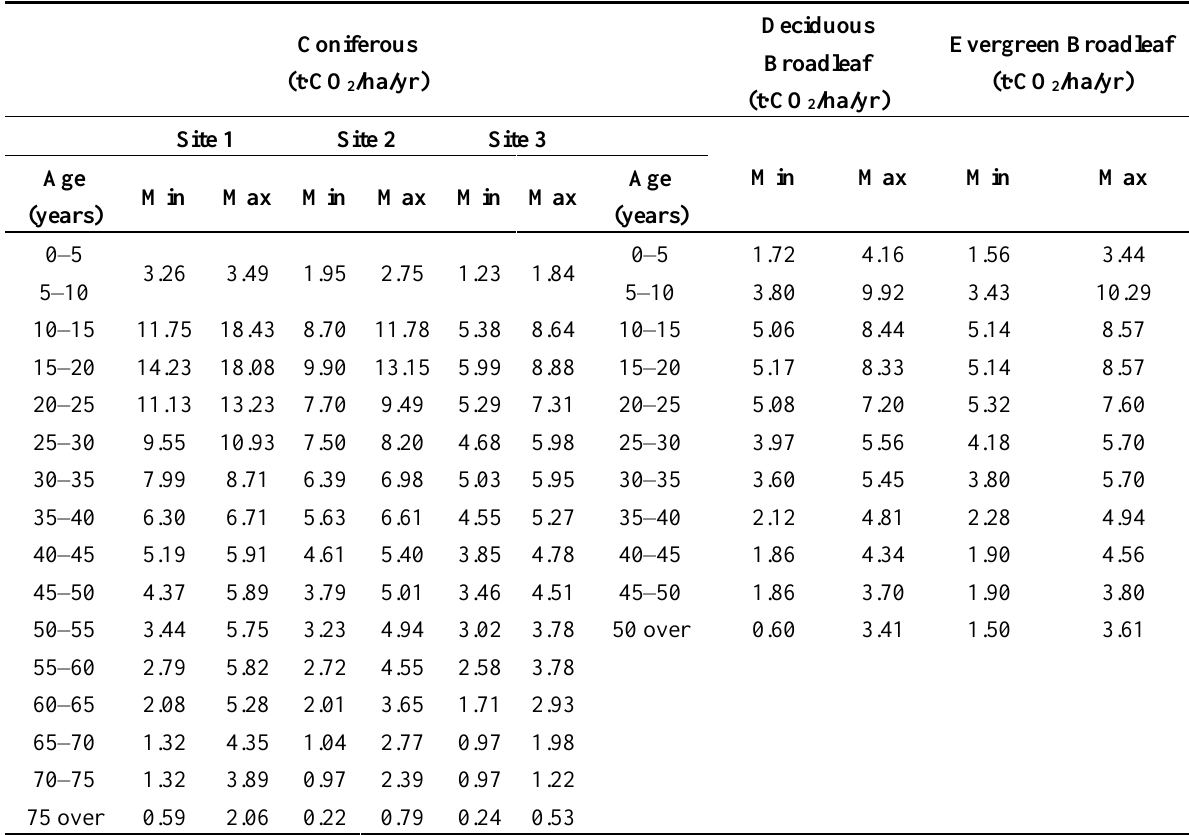
Table 6. CO 2 sequestration minimum and maximum values for each forest type and tree age